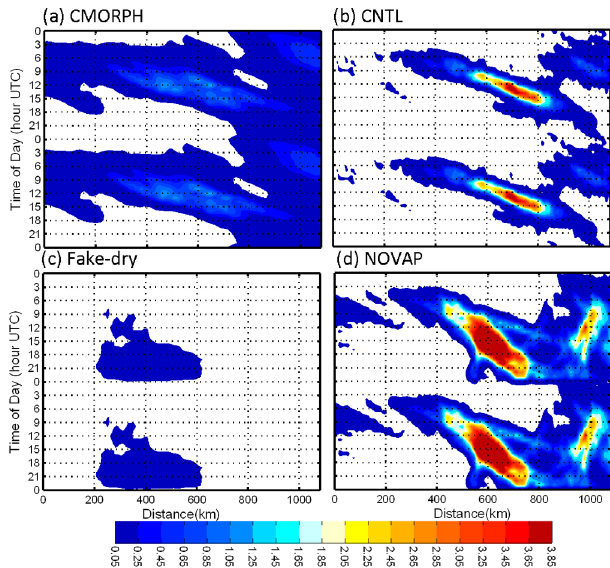
Fig. 6. Hovm¨oller diagram of the rain rate (mmh − 1 ) averaged along the cross northwest–southeast cross section over ABEF for (a) 17– 24 June 2004 from CMORPH; (b) the final 10 days of CNTL; (c) the 10 days of Fake-dry; (d) the 10 days of